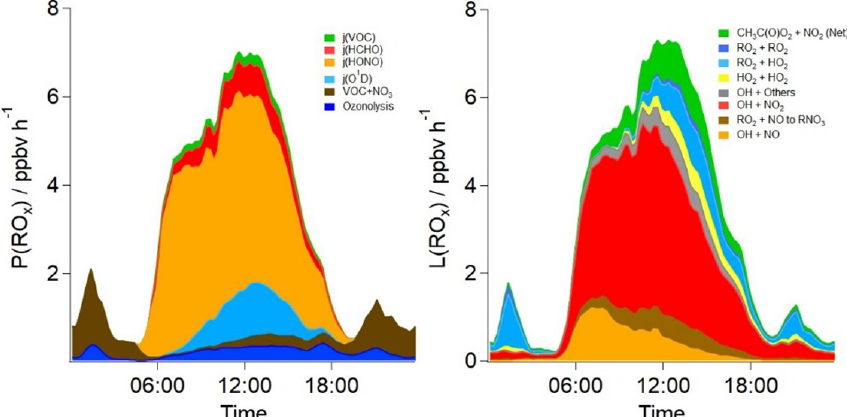
Figure 8. The average diurnal rates of primary production and termination for RO x radicals in parts per billion per hour (ppbvh − 1 ) in the base model scenario. CH 3 C ( O ) O 2 + NO 2 (Net) represents the net rate (forward minus backward) for all RC ( O ) O 2 + NO 2 ↔ PAN